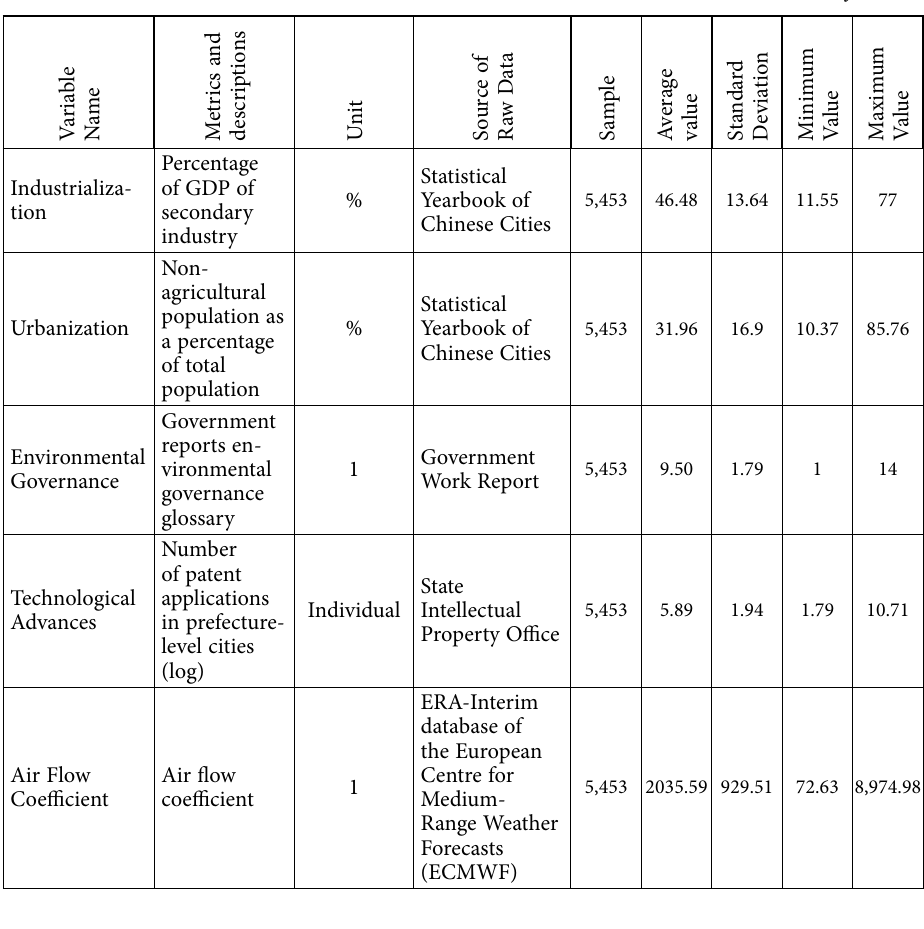
Table 2. Variable selection reference Selected Variable